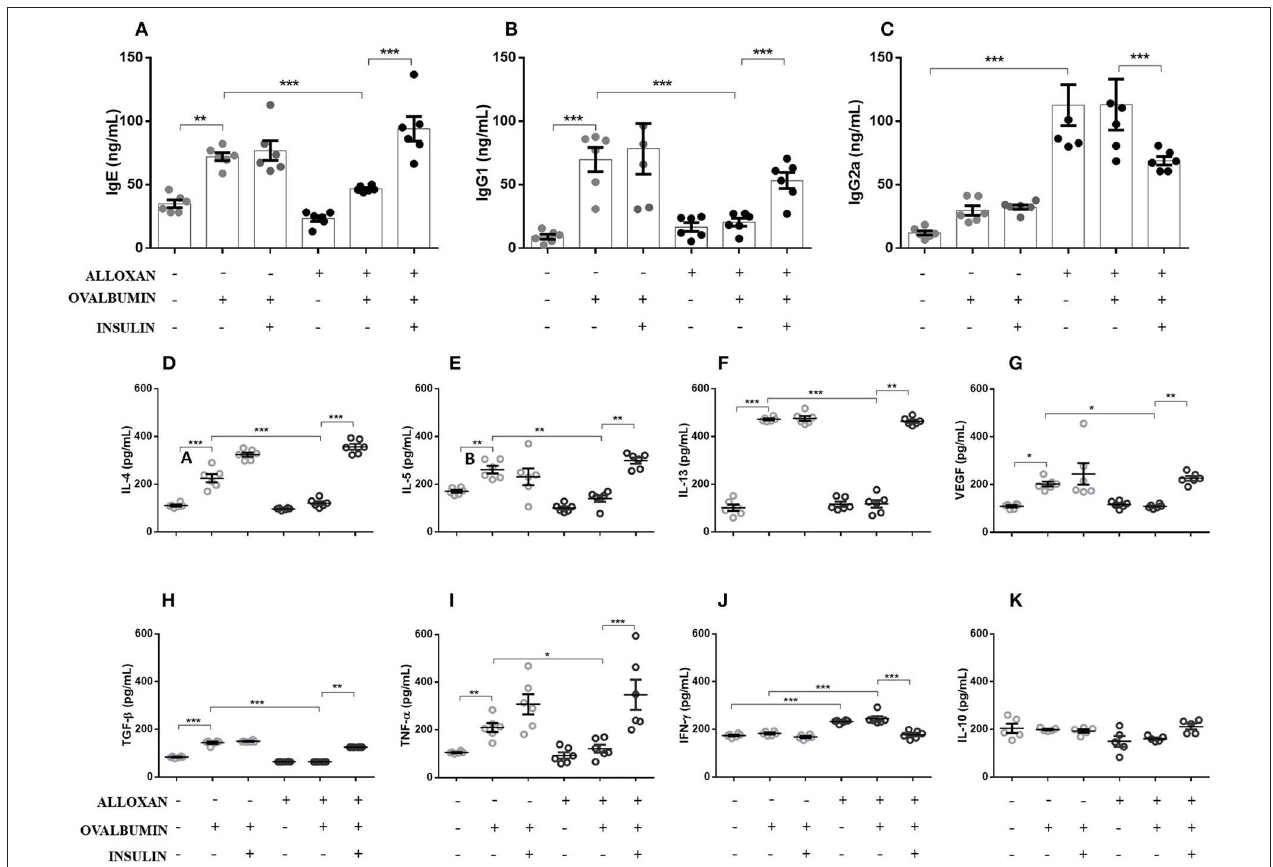
FIGURE 2 | Effects of insulin on the secretion of immunoglobulins and cytokines in serum and lung homogenates, respectively. After collecting whole blood via cardiac puncture from animals in the different experimental groups, the serum was separated by centrifugation at 1,600 rpm for 20min to evaluate the serum levels of (A) IgE, (B) IgG1, and (C) IgG2a. Lung tissues were collected and homogenized in RIPA buffer, and the supernatant was used in ELISAs to determine the levels of the following cytokines: (D) IL-4, (E) IL-5, (F) IL-13, (G) VEGF, (H) TGF- β , (I) TNF- α , (J) IFN- γ , and (K) IL-10. Values represent the mean ± SEM from three